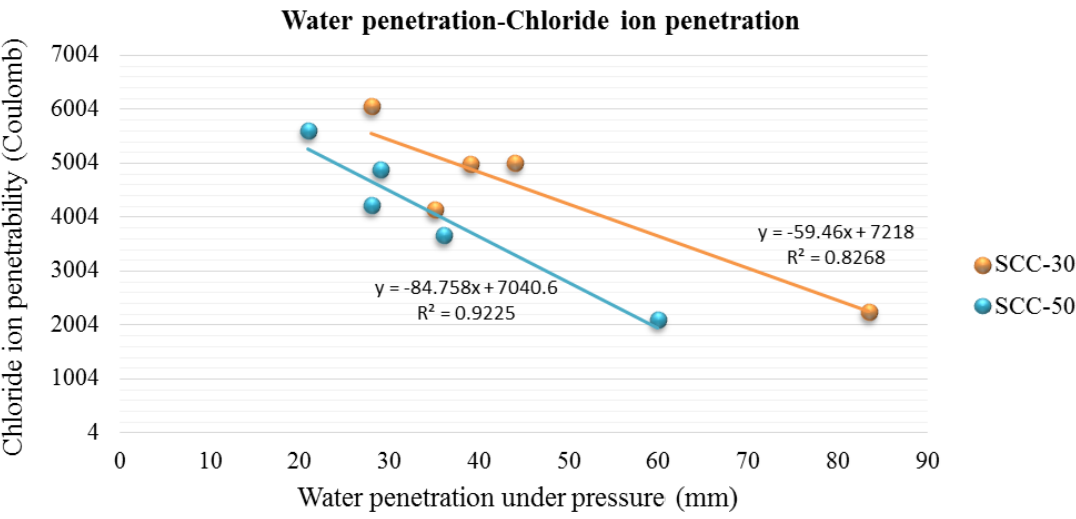
Figure 10. Water penetration under pressure-Chloride ion penetration of series SCC-30 and SCC-50.